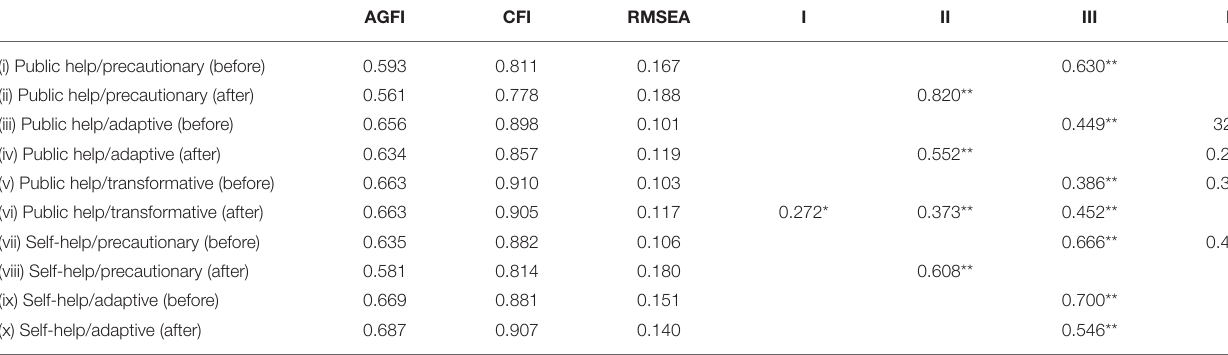
TABLE 9 | Goodness-of-fit indicators and standardized path coefficients for structural equation models (SEM) analysis results. AGFI CFI